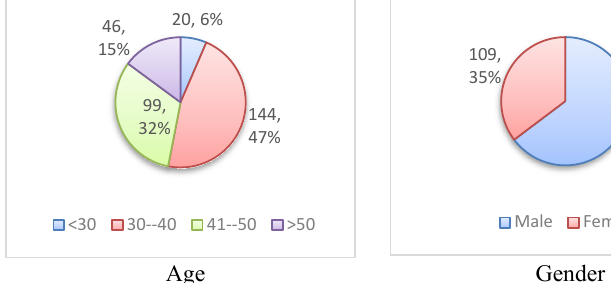
Fig. 2. Background of the Respondents